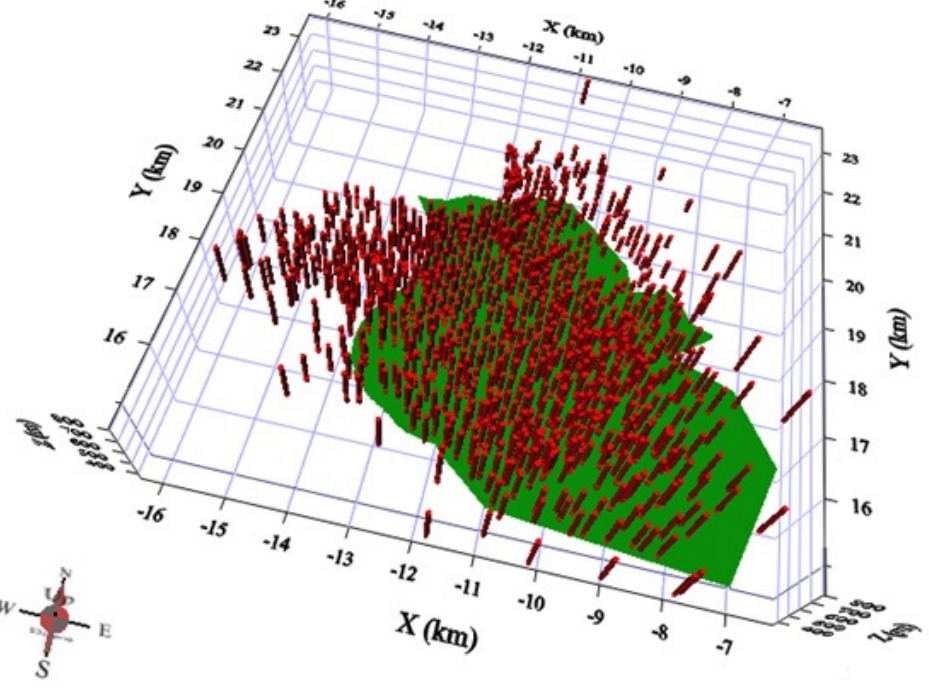
Figure 5. Positions of boreholes (red color) and mining area (green color).